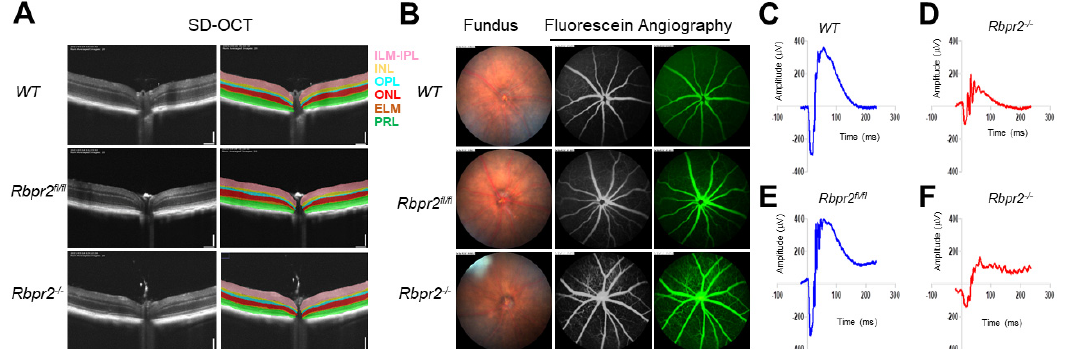
min A restriction. ( A ) OCT retinal analysis of 12-week old controls (WT, Rbpr2 fl/fl ) and homozygous Rbpr2 − / − mice on vitamin A-deficient diets. Note that the photoreceptor cell layer is reduced ( p < 0.05) in Rbpr2 − / − mice compared to controls. ( B ) Fundus imaging of 12-week old wild-type (WT), floxed ( Rbpr2 fl/fl ), and homozygous ( Rbpr2 − / − ) mice after intraperitoneal injection with ICG (15 mg/kg, Acros Organics, NJ, USA). Note that blood vessel leakage was observed in Rbpr2 − / − mice compared to con- trols. ( C – F ) Scotopic electroretinograms of 12-week old control ( Rbpr2 fl/fl ) and Rbpr2 − / − mice on vita- min A-deficient diets., Rbpr2 − / − vs. controls at 0.1 cds/m 2 . 3.6. Rod and Cone Opsin Expression Are Reduced in Rbpr2 − / − Mice